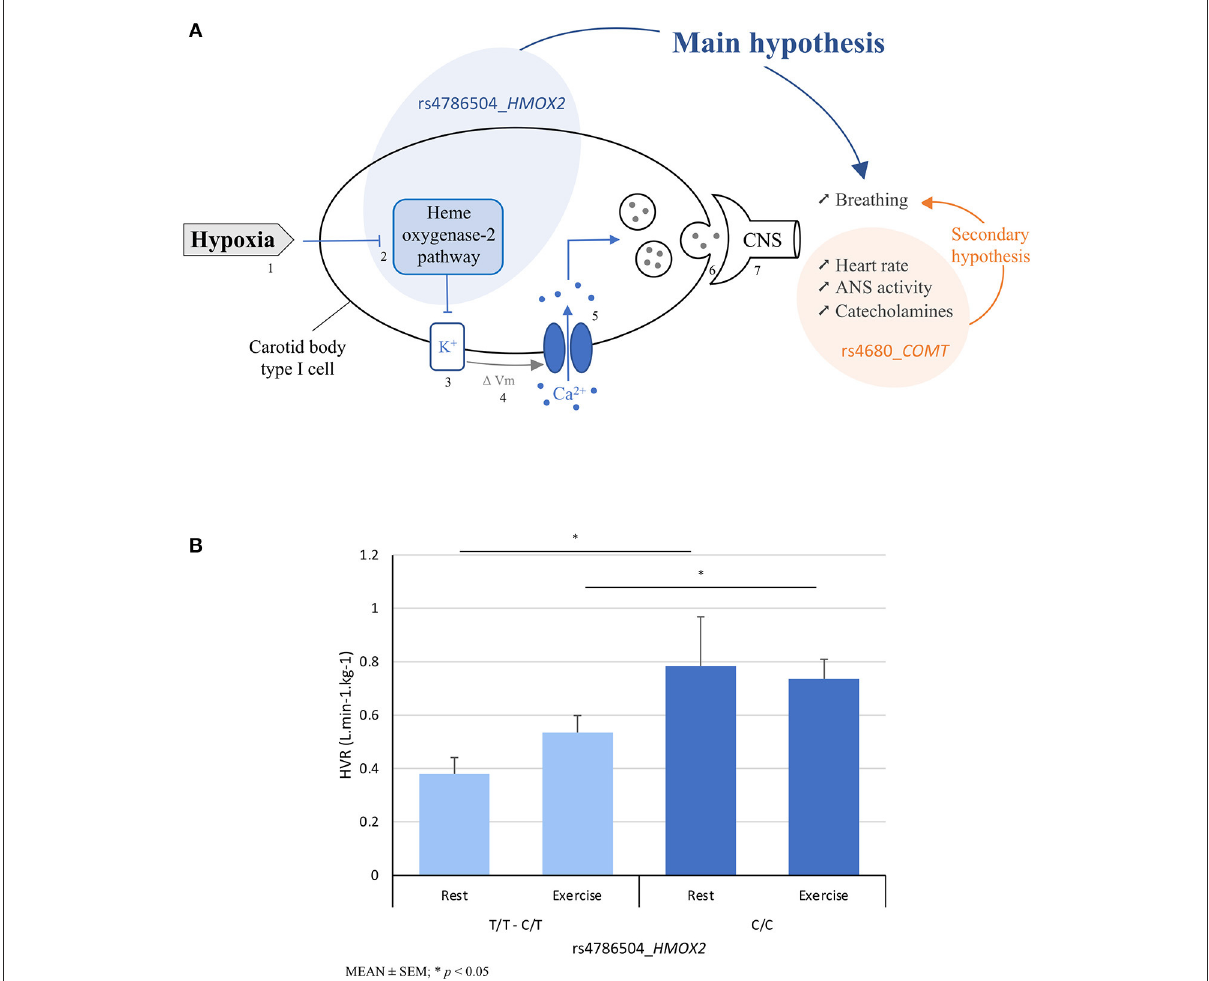
FIGURE1 (A) Hypotheses using the schematic representation of the heme oxygenase-2 (HO-2) signaling in the detection of hypoxia by the carotid body: the main hypothesis is based on the association between rs4786504_ HMOX2 polymorphism and breathing (i.e., exercise hypoxic